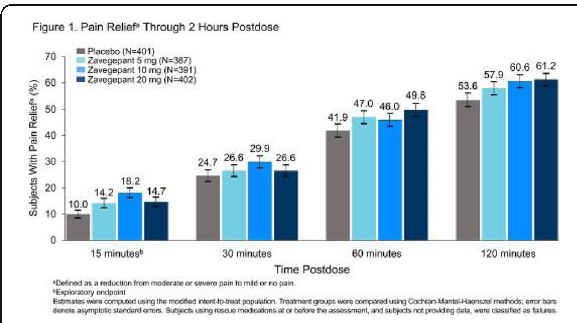
Fig. 1 (abstract P0267). See text for